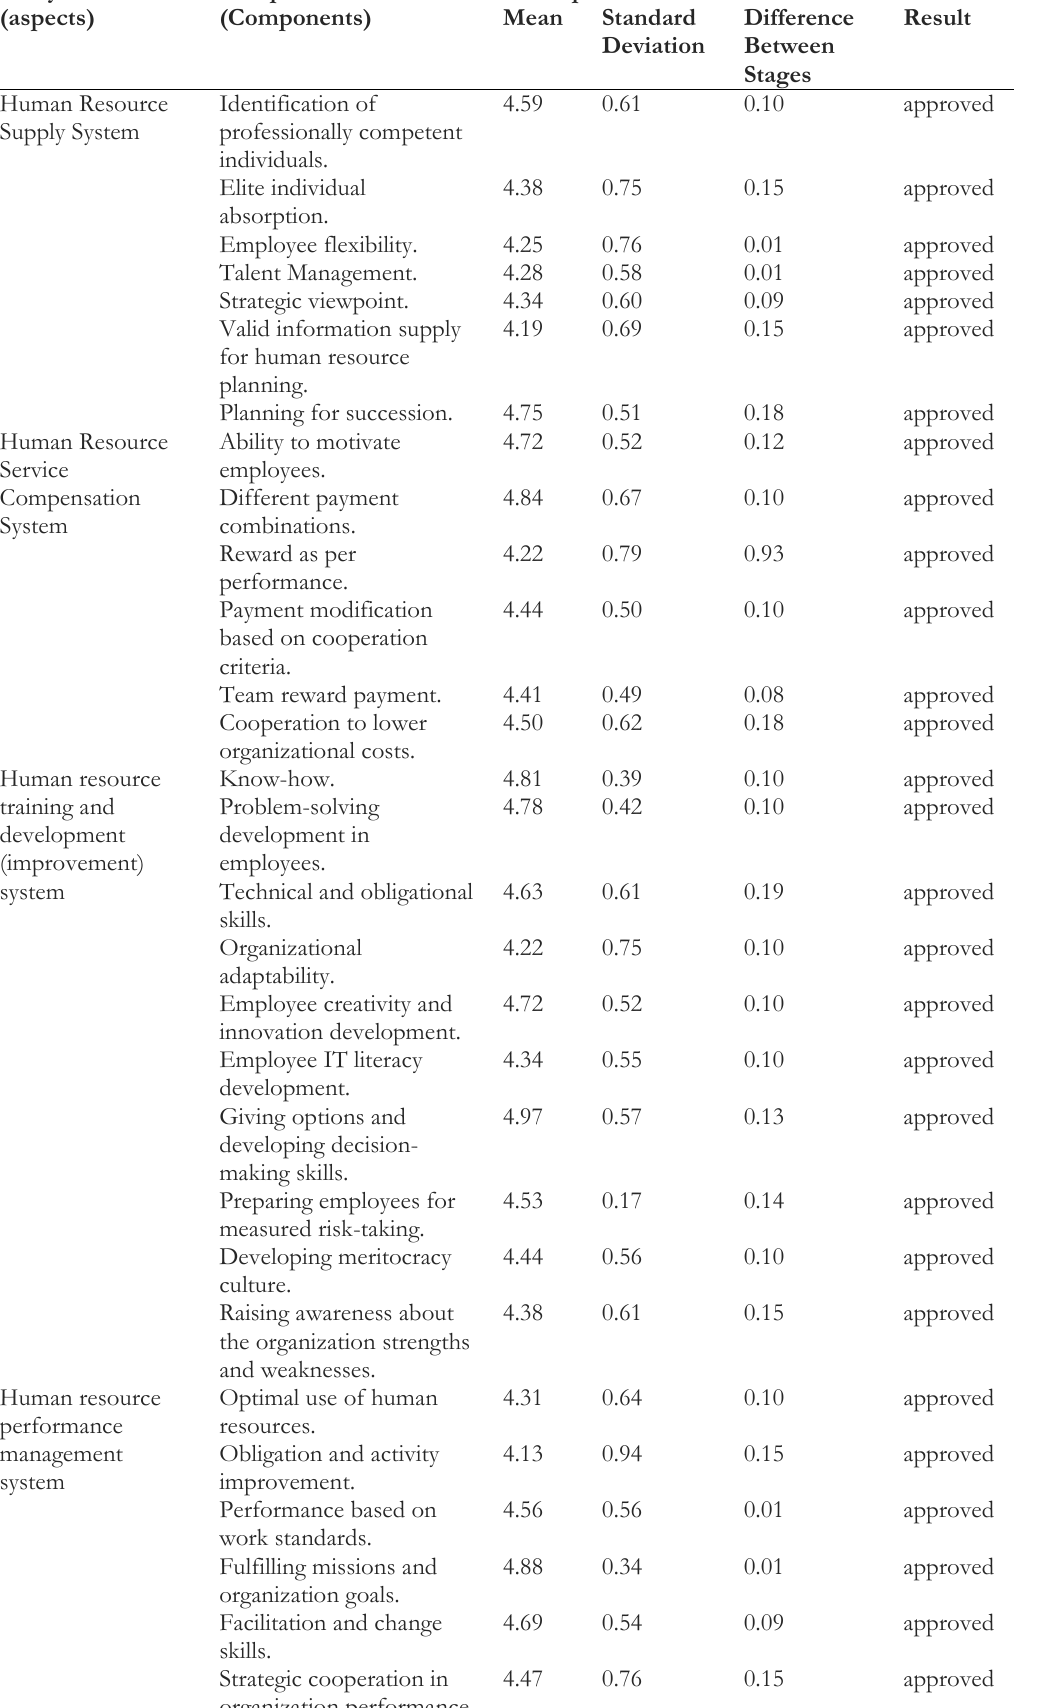
Table 2. Data analysis based on mean, standard deviation, and Delphi method